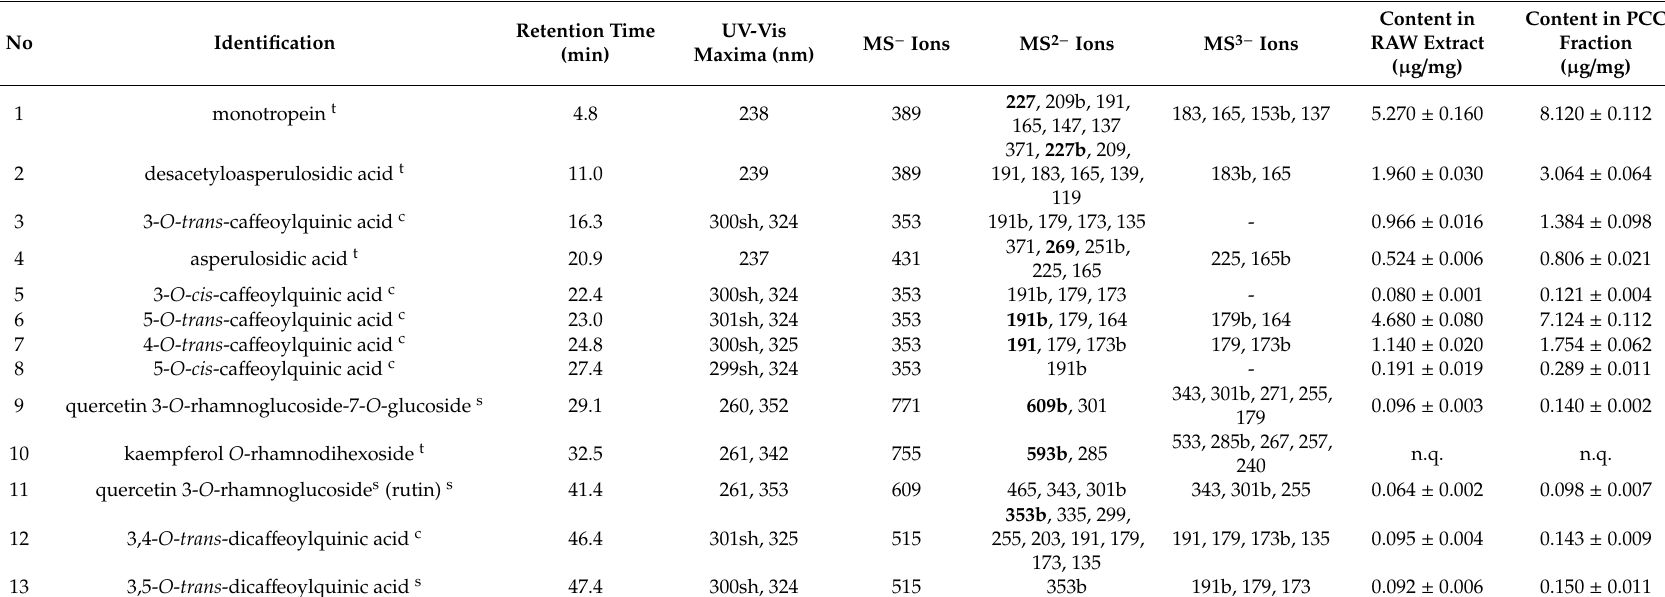
Table 2. UHPLC-DAD-MS and quantification data of aqueous extract and PPC